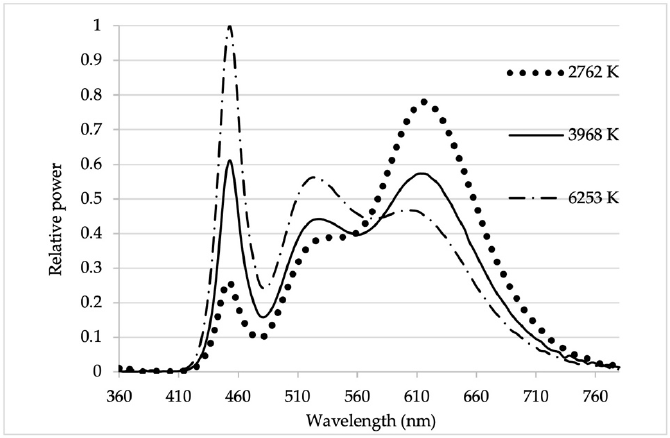
Figure 3. Measured spectral power distributions for 2762 K, 3968 K, and 6253 K light from a commercially available tuneable white lighting system.